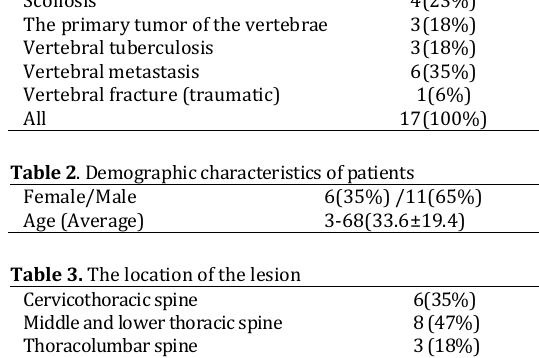
Table 1. Pathology of the spinal column Scoliosis